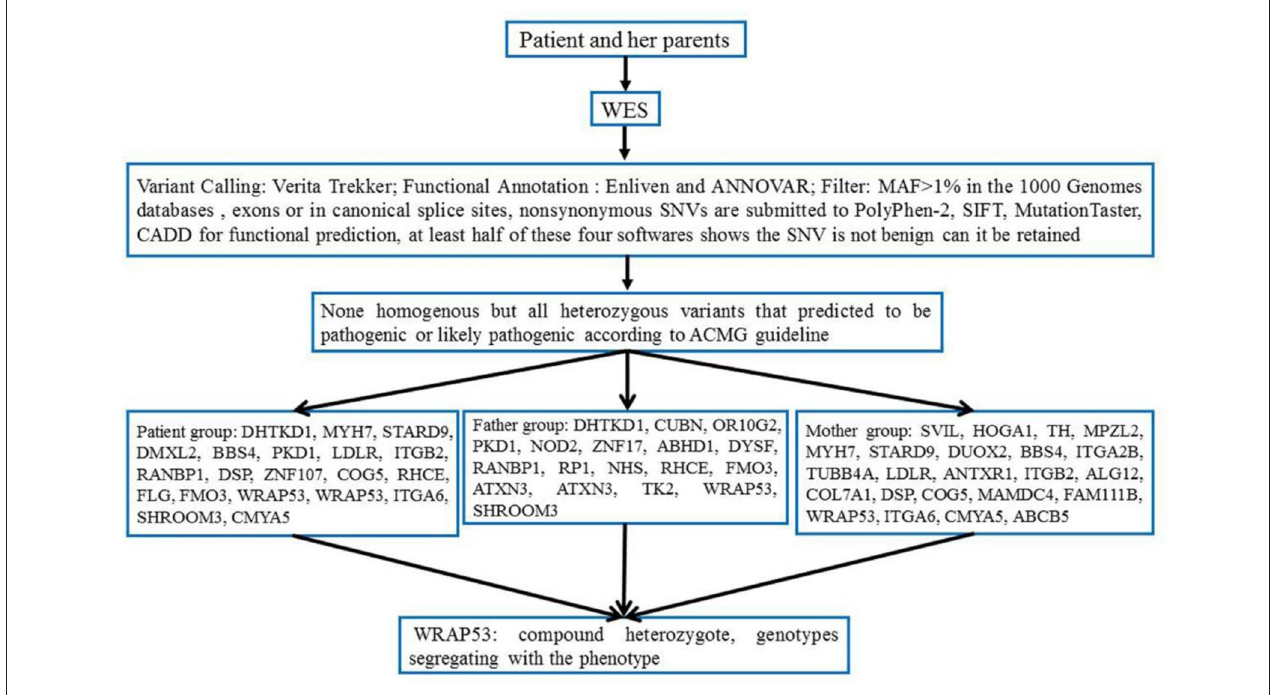
FIGURE 8 | Flowchart of this whole-exome sequencing (WES) study and gene identification.